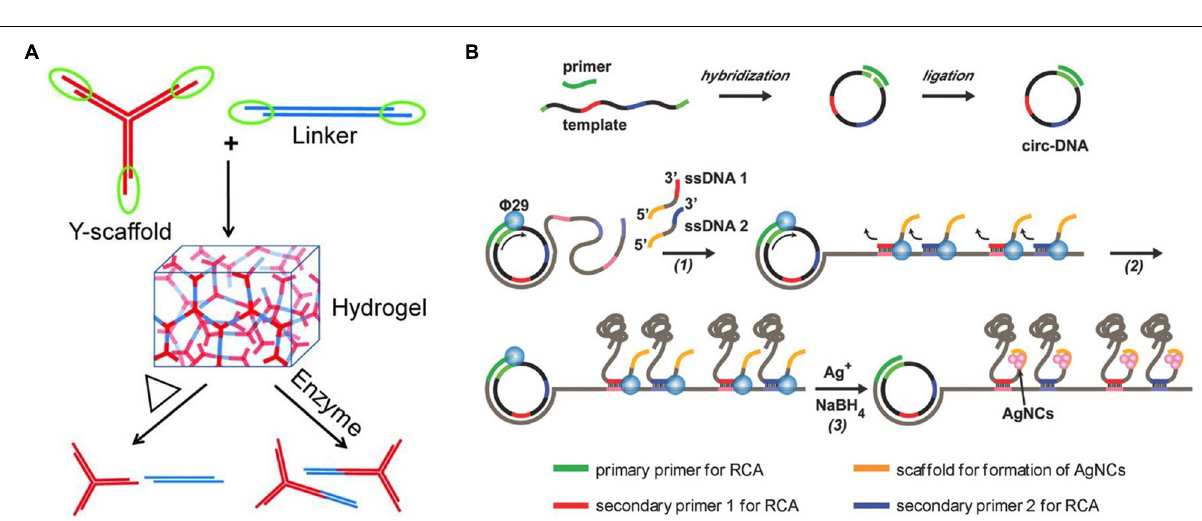
FIGURE 2 | (A) Schematic diagram of the preparation of pure DNA-based hydrogel by hydrogen bonding of Y-scaffold and linker. Reproduced with permission from Xing et al. (2011). Copyright (2011) Wiley-VCH. (B) Schematic diagram of the preparation of biofunctional DNA-based hydrogel by physical entanglement. Reproduced with permission from Geng et al. (2018). Copyright (2018)